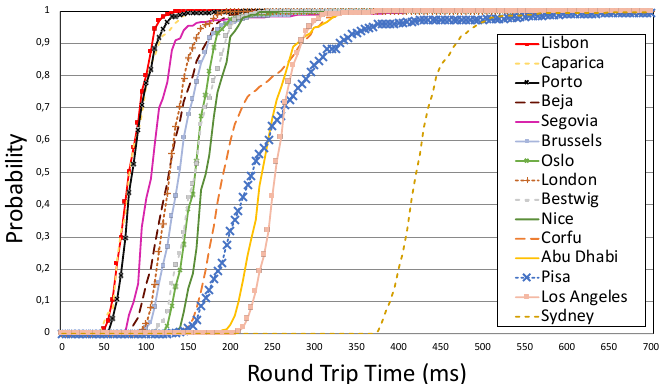
Figure 11. RTT Cumulative Distribution Functions (CDF).